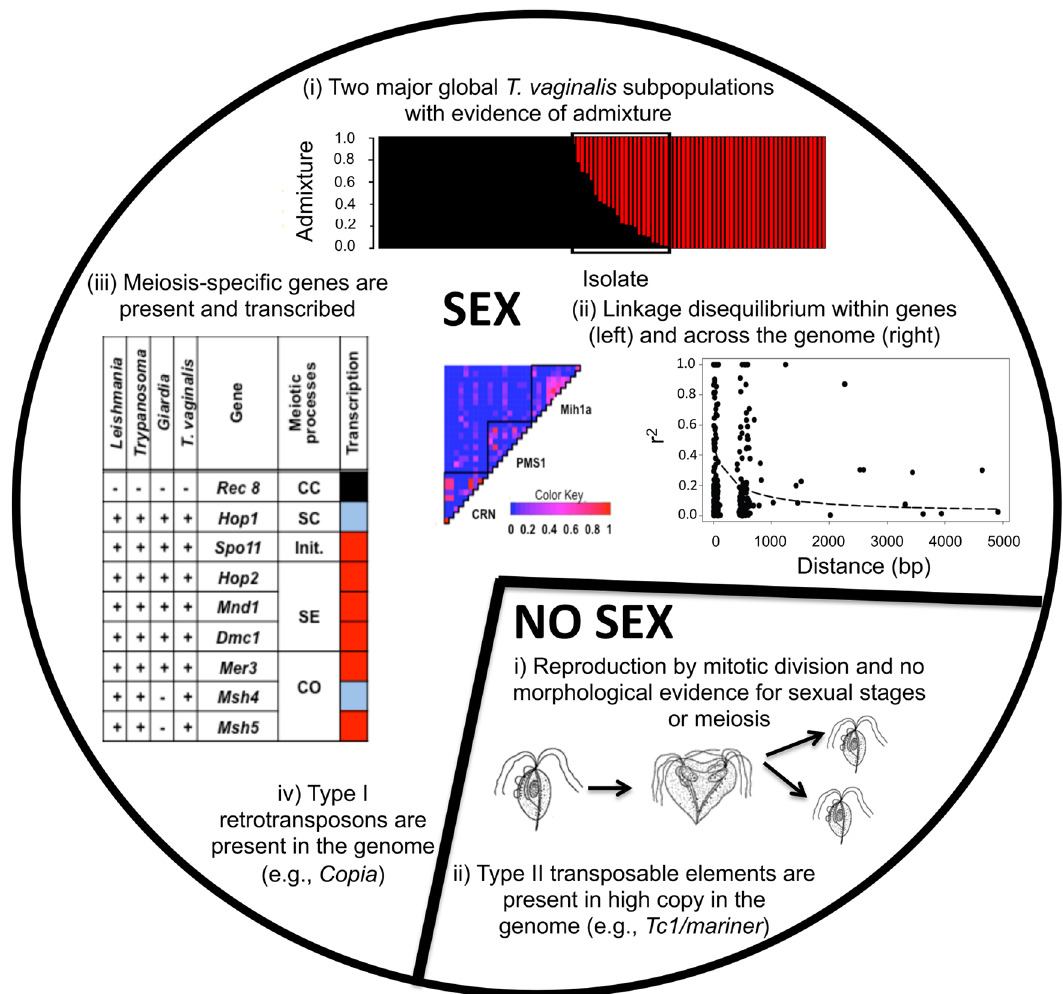
Fig 1. Summary of evidence suggesting sexual or asexual reproduction in T . vaginalis . The large slice (SEX) presents evidence for sexual reproduction: (i) Population admixture plot based on analysis of 3,923 SNP markers in 102 global T . vaginalis isolates (data from [13]). Each column represents a single T . vaginalis isolate and shows the proportion of its genotype as a part of each of two subpopulations (black and red). Isolates containing both black and red genotypes represent potential recombinants between the two subpopulations. (ii) LD decays fast within genes [10], as well as across the genome [13]. A heat map represents the degree of LD between 49 SNPs in three single-copy genes, with r 2 (the standardized measure of LD between pairs of SNPs) colored according to low LD (0; blue) and high LD (1; red); black lines indicate gene boundaries. The graph shows LD decay (r 2 , y-axis) calculated over 5-kb intervals (distance, x-axis) in 2,837 SNPs from 872 T . vaginalis contigs. Each point represents the average LD between two SNPs that are 5 kb apart. (iii) Homologs of nine major meiosis-specific genes are present in T . vaginalis and other sexually reproducing protozoan parasites [15]. Transcription of eight of these genes (excluding Rec8 [black square]) is detectable at levels above (red squares) or below (blue squares) the average expression of all T . vaginalis genes (RNA next generation sequencing [RNA-seq] data from [13]). (iv) The presence of Type I retro TEs (e.g., Copia, a family of long terminal repeat elements that move by means of an RNA intermediate, common in animals, fungi, protista, and plants), suggests sexual recombination in T . vaginalis . The small slice (NO SEX) presents evidence for asexual reproduction: (i) No visible sexual stages have been identified for T . vaginalis under any conditions tested. (ii) A high abundance of extremely similar Type II TEs (e.g., Tc1/mariner, a family of transposons found throughout metazoa that use a cut-and-paste mechanism to transpose) implies their accumulation due to a lack of sexual reproduction. CC, cohesin complex; CO, crossover; Init., initiation of double-strand break; LD, linkage disequilibrium; SC, synaptonemal complex; SE, strand exchange; SNPs, single nucleotide polymorphisms.